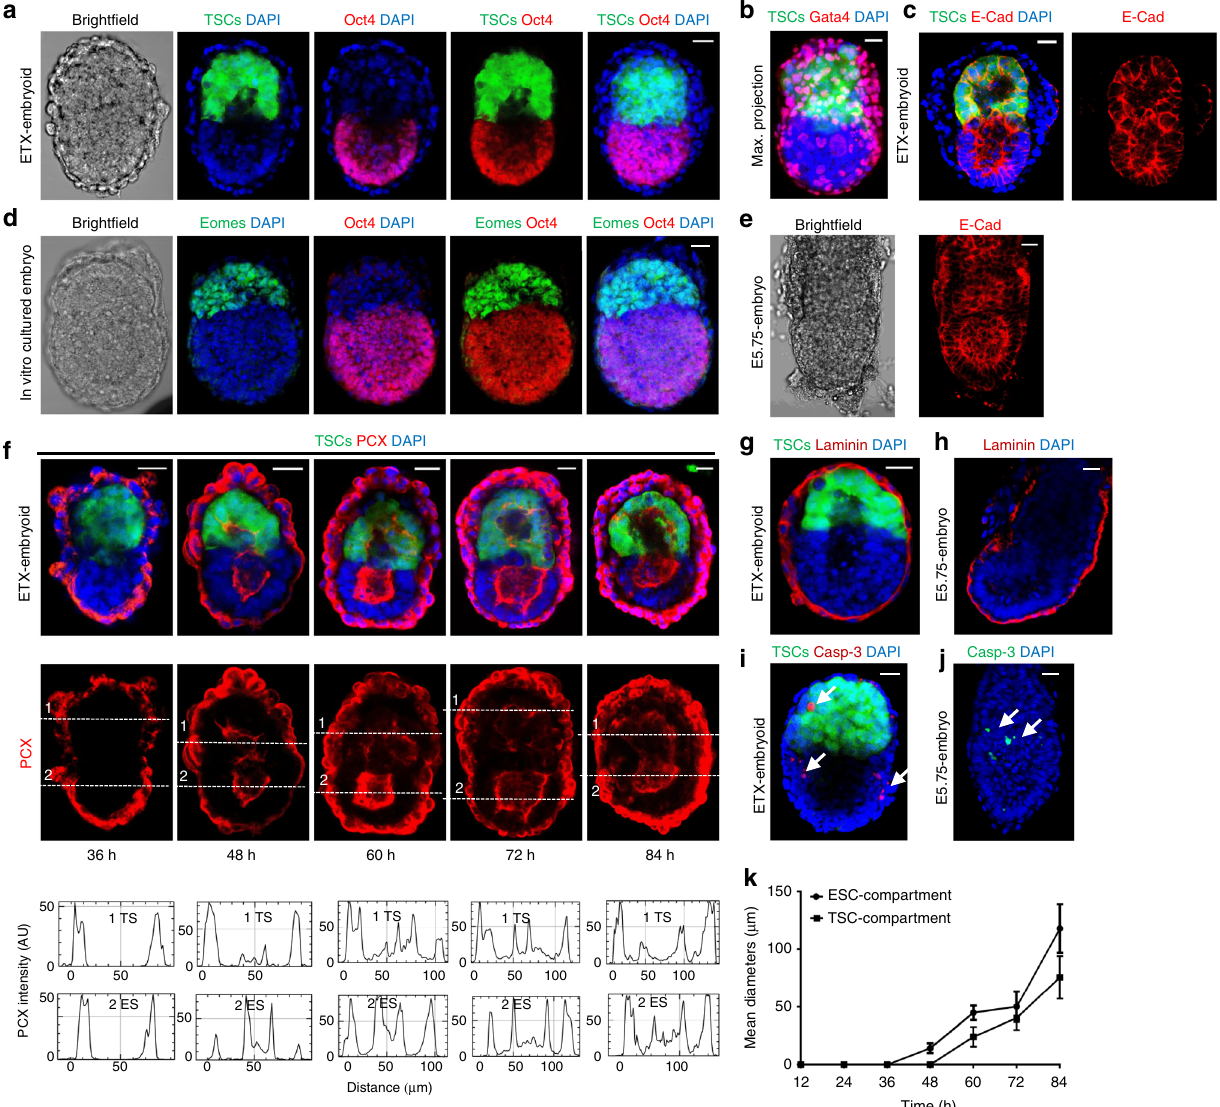
Fig. 3 Pro-amniotic cavity formation in ETX-embryoids. a Localization of ESC-, TSC-, and XENC-derived tissues in ETX-embryoids at 84 h. The green cells are from EGFP-TSCs, Oct4 (red) indicates ESC-derived tissues, and DAPI only (blue) cells in the merged image (the right-most panel) show XENC-derived tissues. n = 40 ETX-embryoids. b Representative 3D max. projection image of ETX-embryoids reveals XENC-derived tissues via immunostaining of Gata4 (red). n = 10 ETX-embryoids. c Immunostaining of E-cadherin shows the cavity in ETX-embryoids. E-cadherin (red); TSCs (green) and DAPI (blue). n = 20 ETX-embryoids. d Immunostaining shows the embryonic and extra-embryonic parts of wild-type embryos cultured for 60 h in vitro. Oct4 (red); Eomes (green); and DAPI (blue). n = 11 embryos. e Immunostaining of E-cadherin (red) in wild-type E5.75 embryos. n = 10 embryos. f Representative ETX- embryoids after in vitro culture for 36, 48, 60, 72, and 84 h during the progression of cavitation. No cavities in the ESC compartment and TS compartment at 36 h, PCX accumulation along the apical side of cells in the ESC compartment by 48 and 60 h and then in TSC compartment by 72 h. PCX lined a single united large common cavity in ETX-embryoids by 84 h. The PCX fl uorescence intensity was indicated in the lower panel. Staining indicates PCX, red; DAPI, blue. g , h Immunostaining shows Laminin niches (red) in ETX-embryoids ( g ). These niches are similar to those in E6.5 wild-type embryos ( h ). n = 10 ETX- embryoids and n = 10 E5.75 wild-type embryos. i , j ETX-embryoid and E5.75 embryo stained for cleaved caspase-3 (red, arrows) and the nuclei are stained with DAPI (blue). n = 18 ETX-embryoids and 8 wild-type embryos. k The mean diameters of the cavities in ESC compartments and TSC compartments of the ETX-embryoids enlarged along with time of in vitro culture. n = 7 ETX-embryoids at least at each time points. Means ± s.d. Source data are provided as the Source Data fi le. Scale bar, 20 µ m. ETX-embryoid experiments were repeated at least three times ( a , b , c , f , g , i ), and wild-type embryo experiments were repeated at least two times ( d , e , h , j